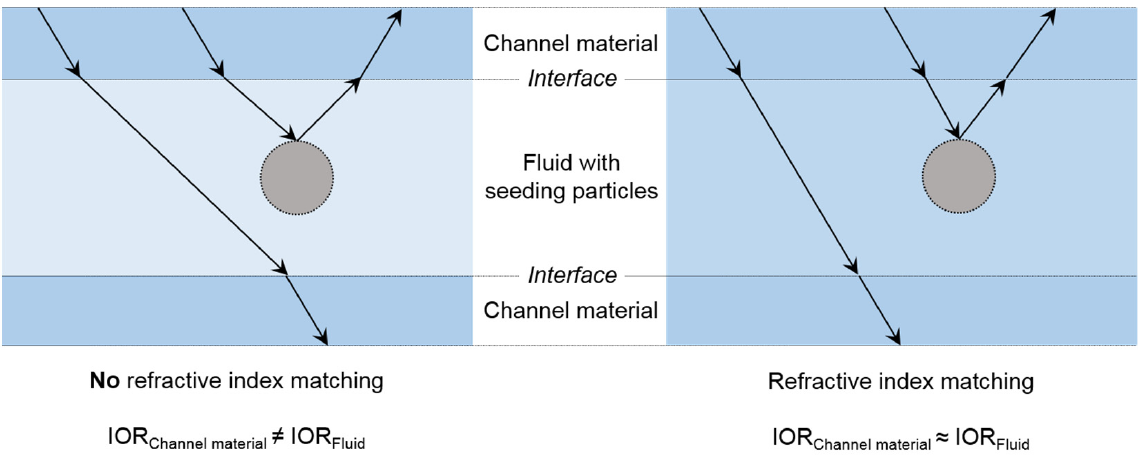
motion. In Figure 3, IOR matching is schematically drawn for fluids with and without PIV seeding particles.